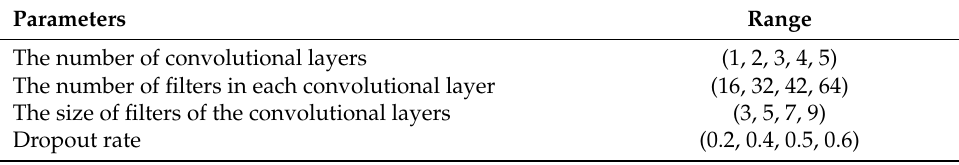
Table 4. Hyper-parameters tuning demonstration.